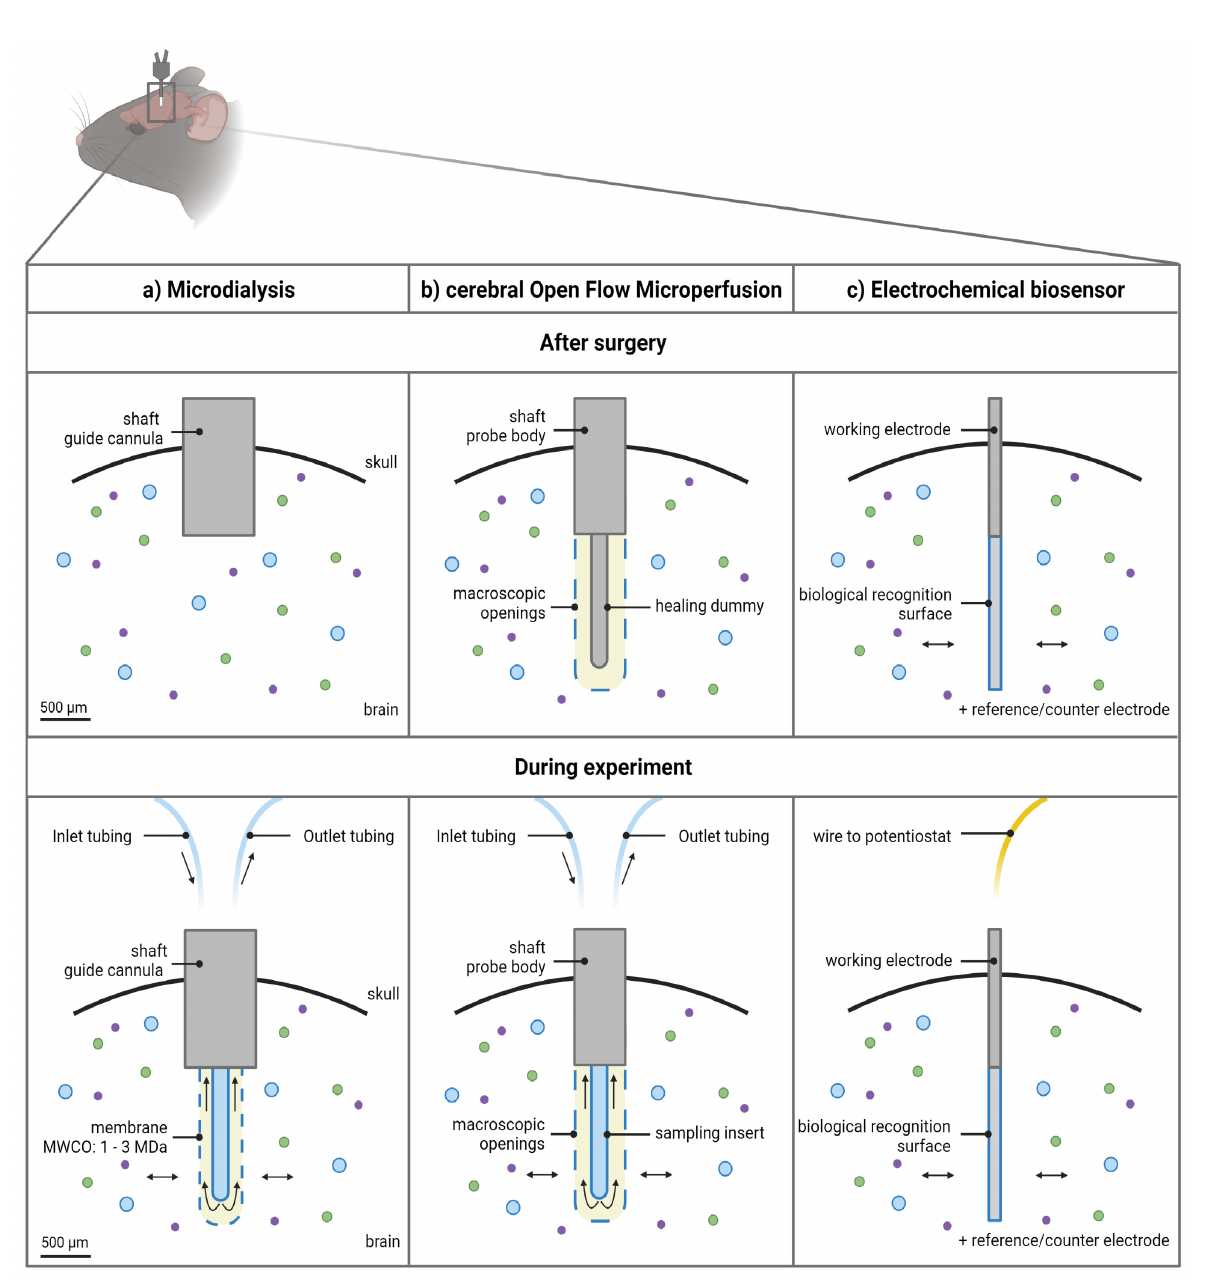
Figure 2. Schematic overview of the 3 approaches to monitor macromolecules directly from the cerebral interstitial fluid. ( a ) The microdialysis probe construct consists of a guide cannula containing a healing dummy implanted in the brain above the region of interest. Before initiating the experiments, the healing dummy is replaced by the probe connected to the tubings. The membrane protrudes beneath the guide cannula. Dimensions of the outer diameter of the shaft of the guide cannula and probe membrane are based on an AtmosLM™ probe. ( b ) The cerebral open flow microperfusion probe body construct/guide itself contains the open exchange area with macroscopic openings and is implanted directly into the brain in the region of interest. Before initiating the experiments, the healing dummy is replaced with the sampling insert connected to the tubings. ( c ) The electrochemical biosensor setup consists of the working electrode (cylinder type is shown), which is implanted in the brain region of interest, while the reference electrode can be implanted in the cortex and the counter electrode can be attached to an anchor screw placed in the skull (not shown). Scale bar indicates 500 µm. Figure created with BioRender.com accessed on 6 April 2022. MWCO: molecular weight cut-off.